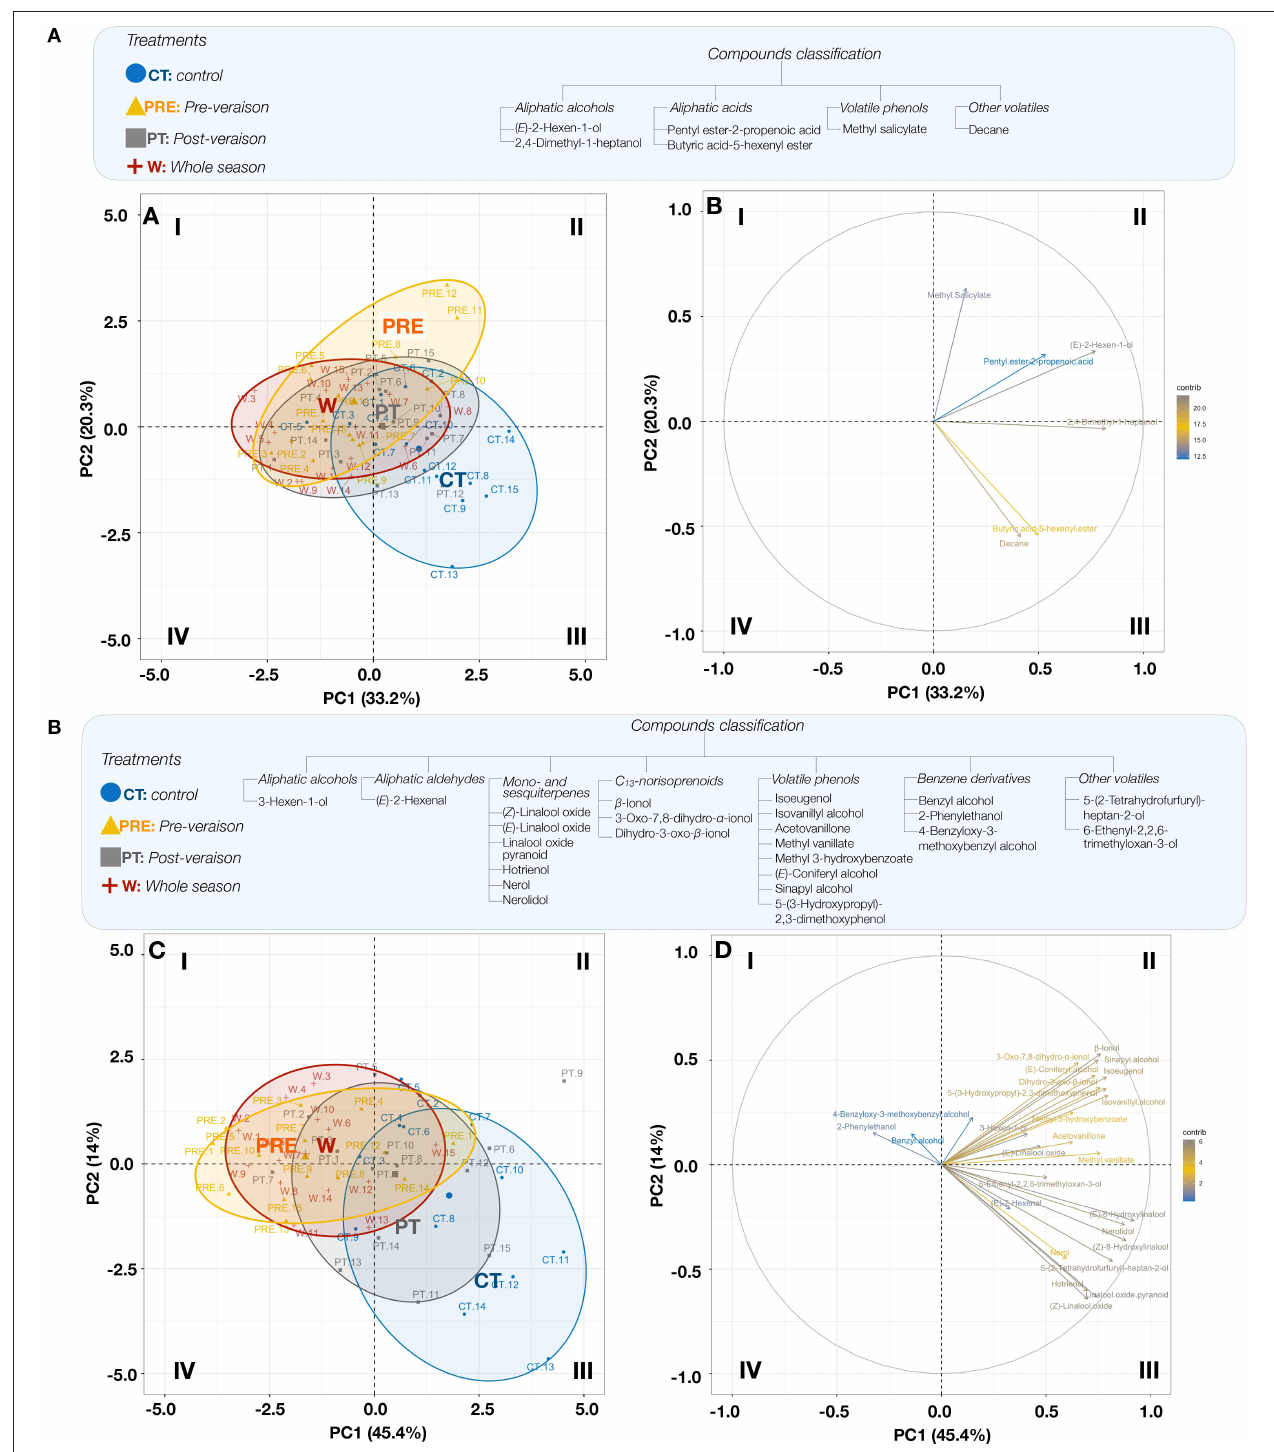
FIGURE 3 | PCA of FVCs (A) and GVCs (B) (variables; right plot), plotted according to the treatments (CT, control; PRE, pre-veraison; PT, post-veraison; W, whole season; samples; left plot). Biological replicates are labeled 1 to 15. FVCs include the following variables: ( E )-2-hexen-1-ol, 2,4-dimethyl-1-heptanol, pentyl ester-2-propenoic acid, butyric acid-5-hexenyl ester, methyl salicylate and decane. GVCs include the following variables 3-hexen-1-ol, (E)-2-hexenal, (Z)-linalool oxide, ( E )-linalool oxide, linalool oxide pyranoid, hotrienol, nerol, nerolidol, β -ionol, 3-Oxo-7,8-dihydro- α -ionol, dihydro-3-oxo- β -ionol, isoeugenol, isovanillyl alcohol, acetovanillone, methyl vanillate, methyl 3-hydroxybenzoate, ( E )-coniferyl alcohol, sinapyl alcohol, 5-(3-hydroxypropyl)-2,3-dimethoxyphenol, benzyl alcohol, 2-phenylethanol, 4-benzyloxy-3-methoxybenzyl alcohol, 5-(2-tetrahydrofurfuryl)-heptan-2-ol, and 6-ethenyl-2,2,6-trimethyloxan-3-ol. Quadrants are identified I-IV